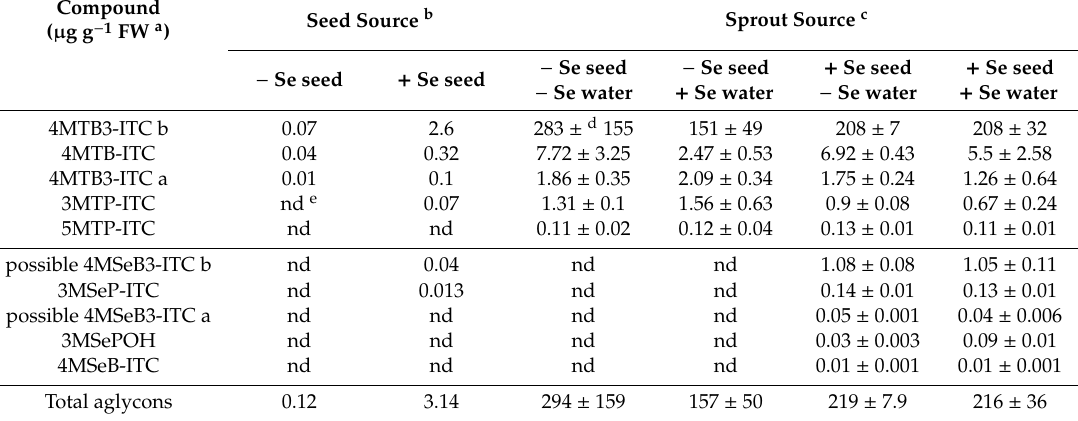
Table 3. Mean nitrile and isothiocyanate hydrolysis product (modified aglycons) content in Raphanus sativus cv. ‘Rambo’ seed sourced from control and selenium (Se)-fertilised plants, and in 5-day-old sprouts produced from the same seed, following germination in the presence or absence of Se. Compounds are listed in order of most to least abundant, with the Se-containing compounds reported